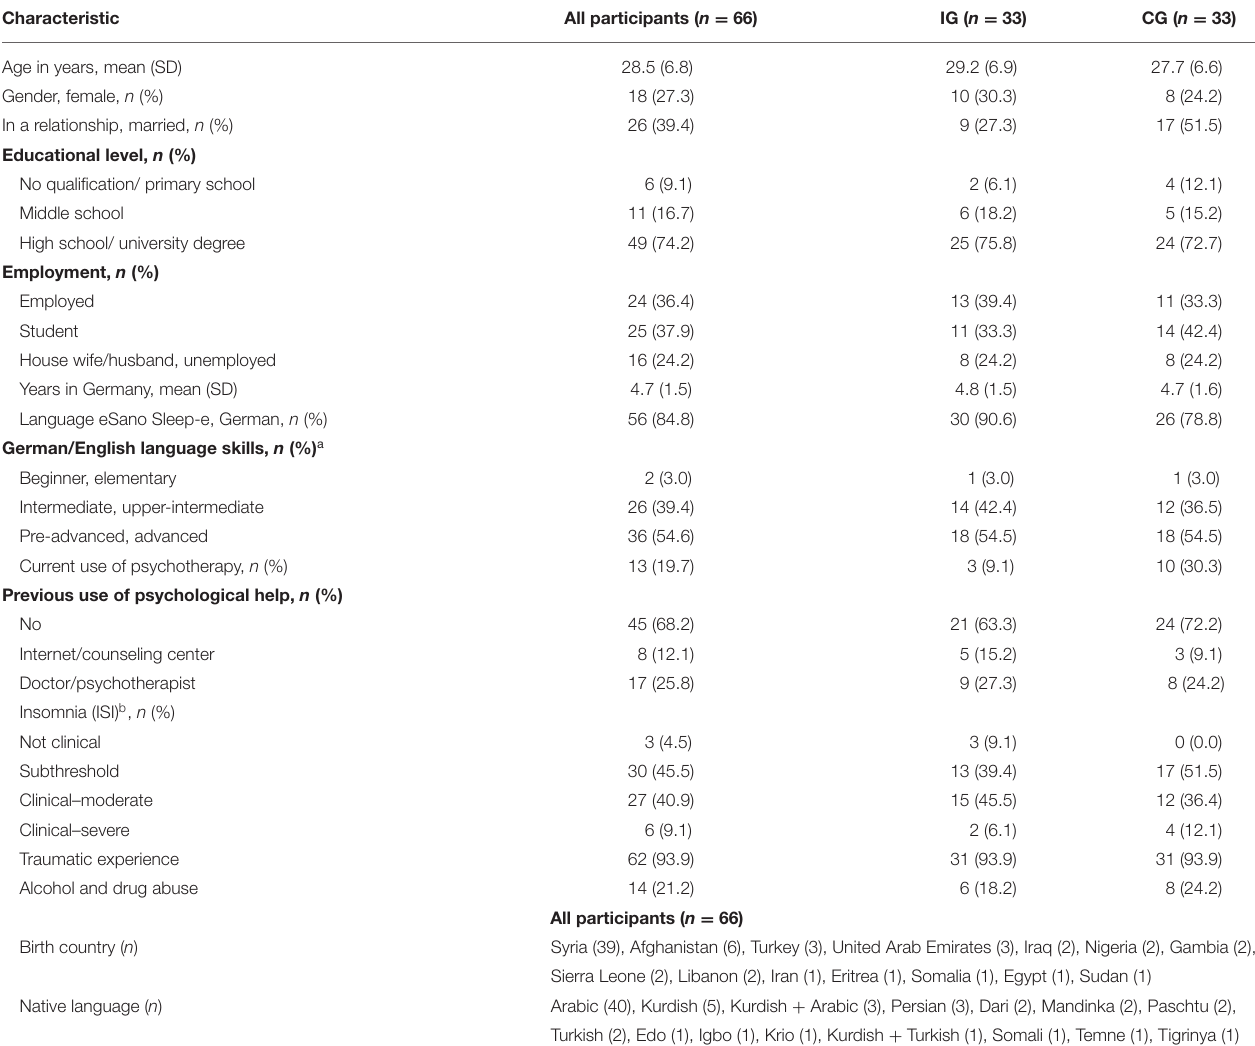
TABLE 2 | Sociodemographic and baseline characteristics of study participants.